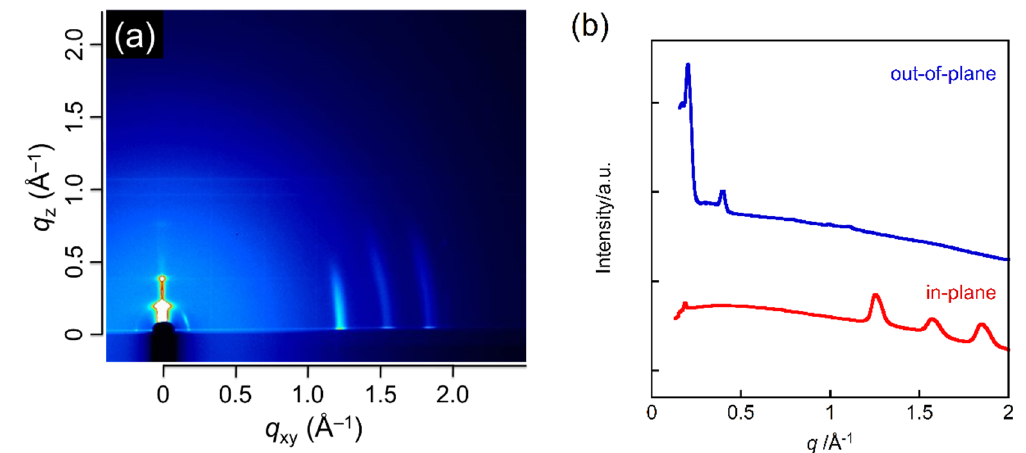
Figure 6. ( a ) Two-dimensional (2D) GIWAXS image and ( b ) one-dimensional (1D) profiles of GIWAXS patterns of C6-DNADT thin film on OTS-modified n + -Si/SiO 2 substrate ( T anneal = 100 °C).